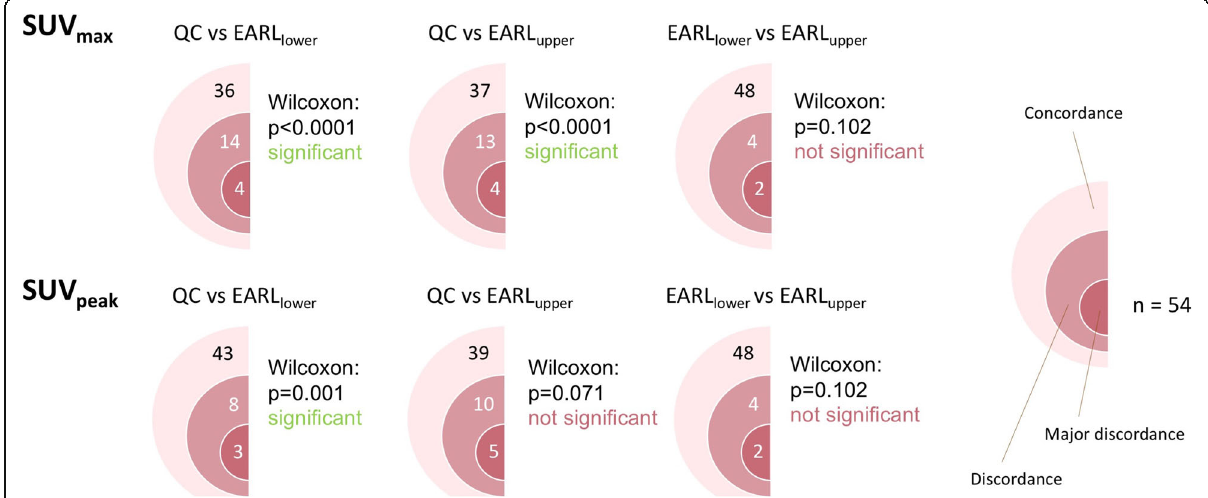
Fig. 3 Diagrams of pairwise comparisons between reconstruction algorithms. Numbers in coloured semi-circles represent n cases that had concordance, discordance and major discordance respectively when comparing reconstruction algorithms pairwise. For SUV max , post hoc analysis with Wilcoxon signed-rank test with Bonferroni correction, QC compared to E lower and E upper respectively yielded significant p value but not for E lower compared to E upper . For SUV peak , only QC compared to E lower yielded significant p